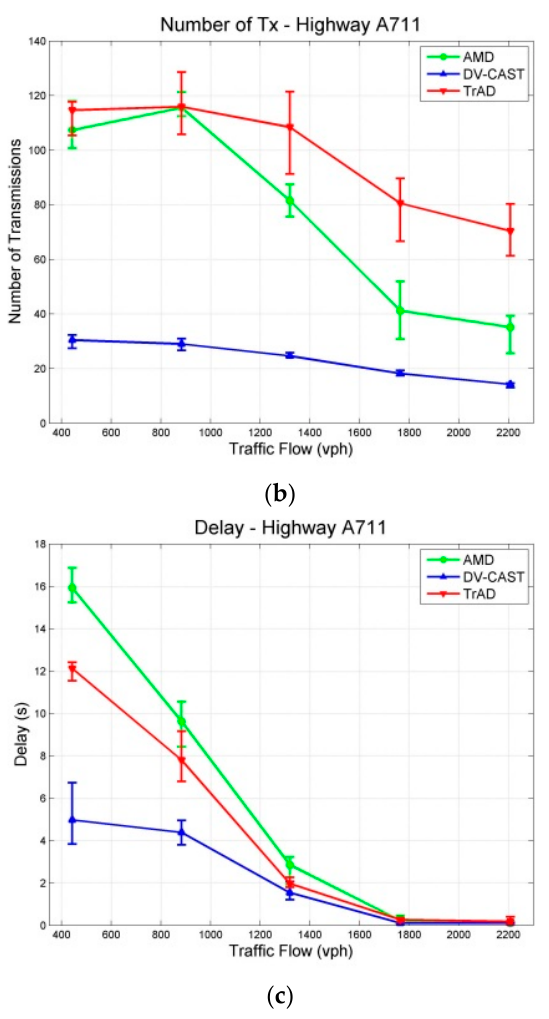
Figure 12. Results with a 95% confidence interval in Highway Scenarios: ( a ) PDR; ( b ) Number of Transmissions; ( c ) Delay.